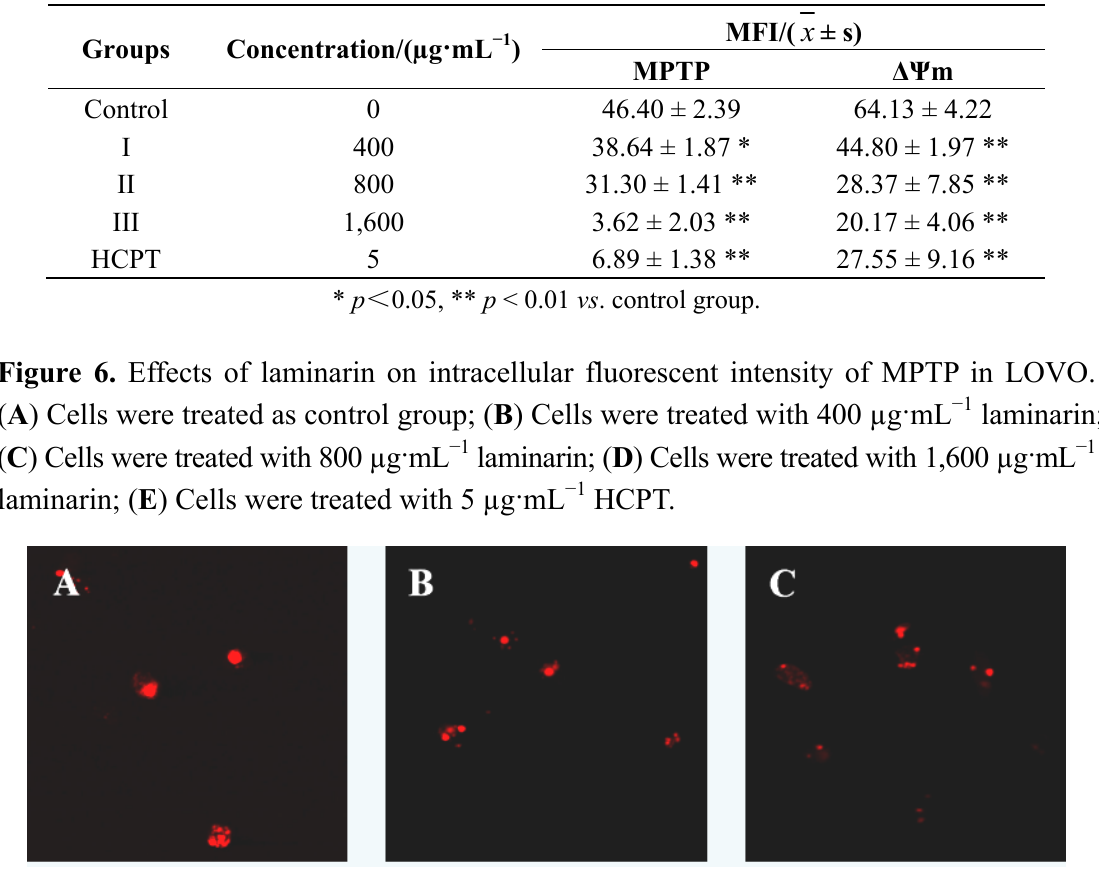
Table 4. Effects of laminarin on activity of MPTP and ΔΨ m in LOVO.